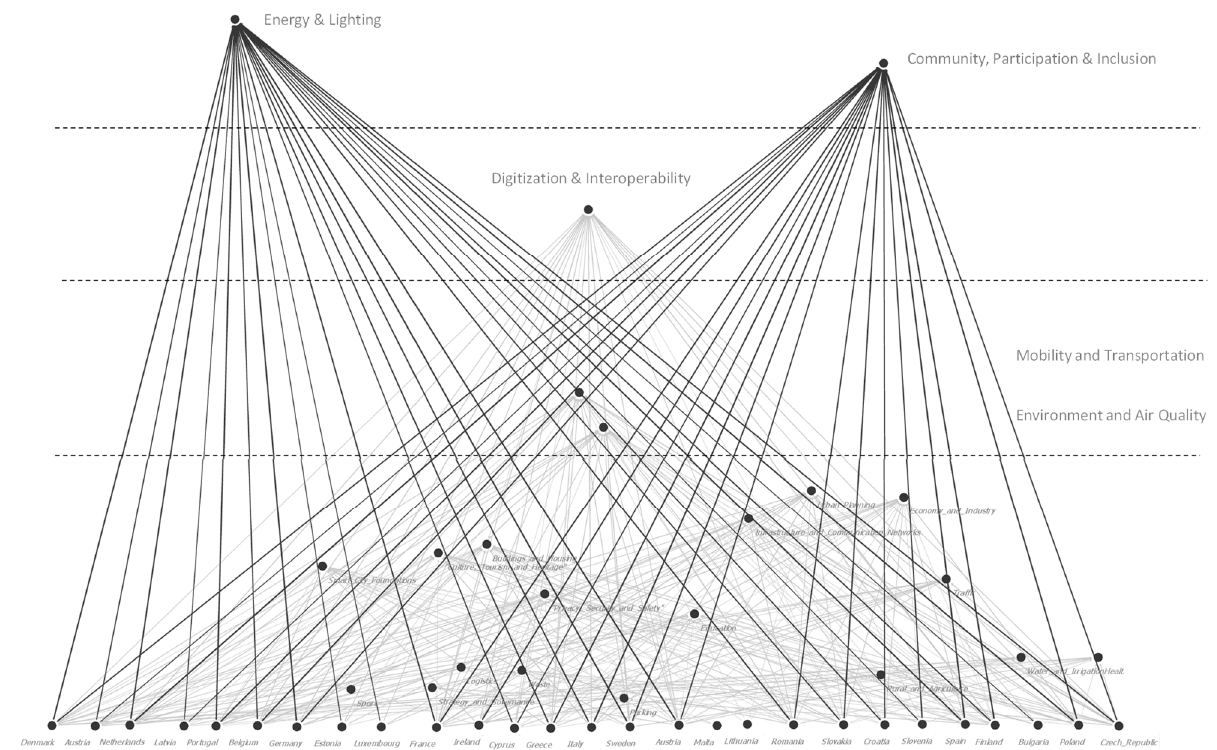
Figure 8. Categories with the widest presence among countries.